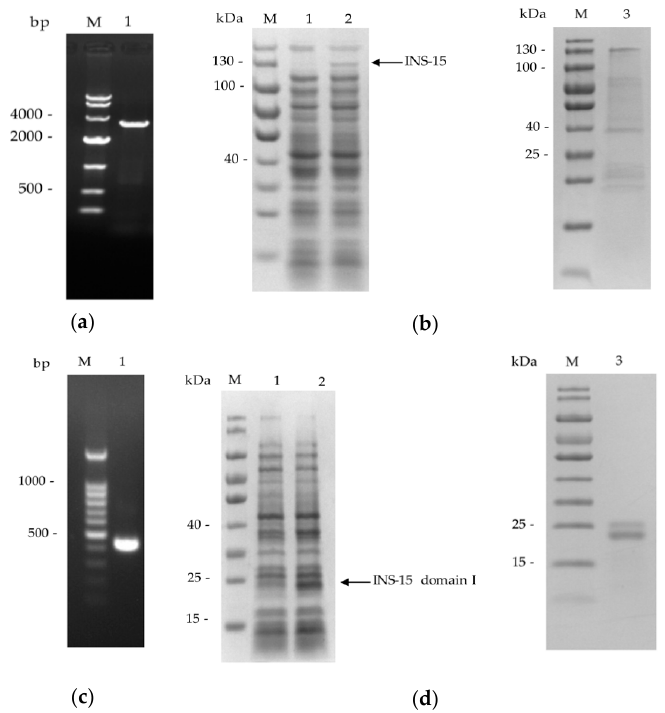
Figure 2. Expression of full-length INS-15 and its domain I in Escherichia coli . ( a ) PCR amplification of the cgd3_4260 gene of C. parvum . Lane M: 1000 bp molecular makers, Lane 1: cgd3_4260 product. ( b ) SDS-PAGE analysis of full-length INS-15 expressed in E. coli (left panel) and purified INS-15 protein from E. coli (right panel). Lane M: molecular weight markers, Lane 1: lysate from recombinant bacteria without isopropyl β -D-thiogalactoside (IPTG) induction, Lane 2: lysate from recombinant bacteria after IPTG induction, with the expected product indicated by an arrow, Lane 3: INS-15 purified from the E. coli lysate using Ni-NTA affinity chromatography. ( c ) PCR amplification of the domain I fragment of the cgd3_4260 gene of C. parvum . Lane M: 100 bp molecular markers, Lane 1: cgd3_4260 domain I